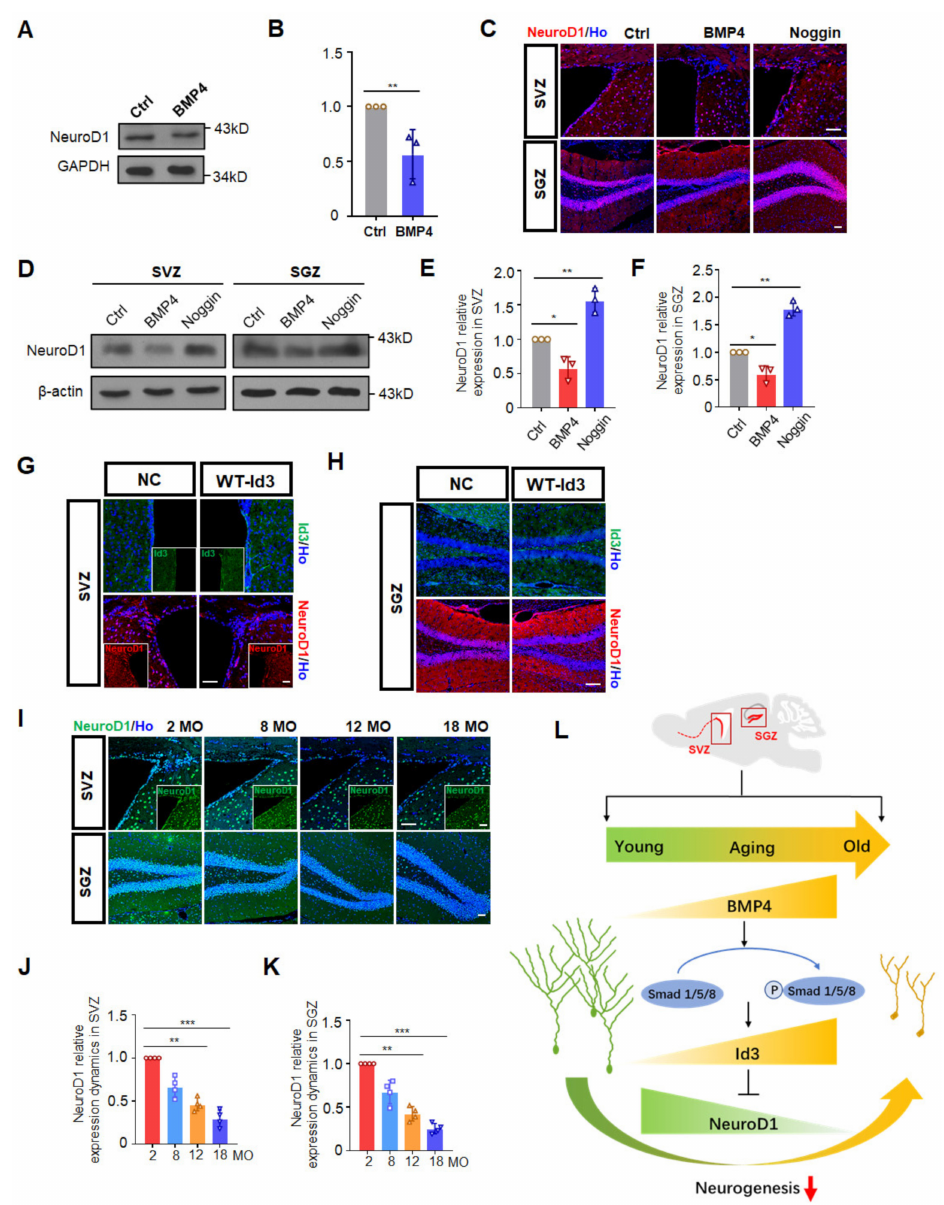
Figure 4. Id3 repressed NeuroD1 to restrain neurogenesis during aging. ( A , B ) Western blotting analysis ( A ) and protein quantification ( B ) of NeuroD1 in ctrl and BMP4 treated C17.2 mouse stem cells. GAPDH is used as a loading control. Data is represented as the mean protein intensity normalized to GAPDH ± S.E.M. ( n = 3). ** p < 0.01. ( C ) Representative images of NeuroD1 expression in the SVZ and SGZ of female mice at 10 MO after saline, BMP4 and noggin infusion. Scale bar, 50 µ m. ( D ) Western blotting analyses of proteins extracted from the SVZ and SGZ from three mice at 10 MO after saline, BMP4 and noggin infusion. β -actin is used as a loading control. ( E , F ) Relative quantification of Western blotting analysis of NeuroD1 levels in the SVZ ( E ) and SGZ ( F ) after the various treatments. Data is represented as the mean protein intensity normalized to β -actin ± S.E.M. from 3 independent mice in each group. * p < 0.05 and ** p < 0.01. ( G ) Representative images of Id3 and NeuroD1 immunostaining in the SVZ of 9 MO female mice ten days after mice were grafted with lentivirus expressing negative control (NC) and wild type Id3 (Id3-WT). Scale bar, 50 µ m. ( H ) Representative images of Id3 and NeuroD1 immunostaining in the SGZ of 9 MO female mice ten days after mice were grafted with lentivirus expressing negative control (NC) and wild type